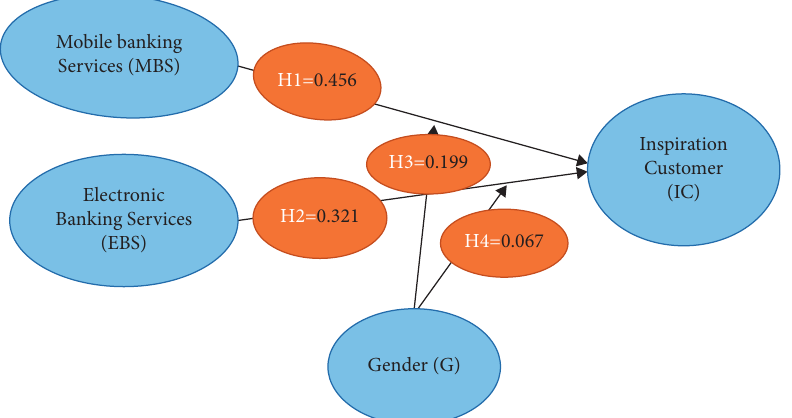
Figure 2: Structural model